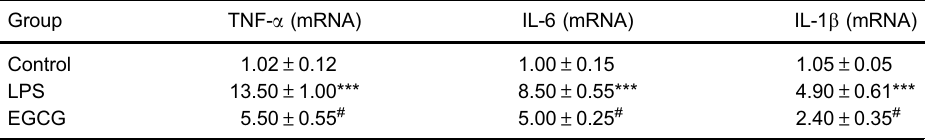
Data are reported as means ± SE. Control group: mice were given saline; LPS group: mice were given